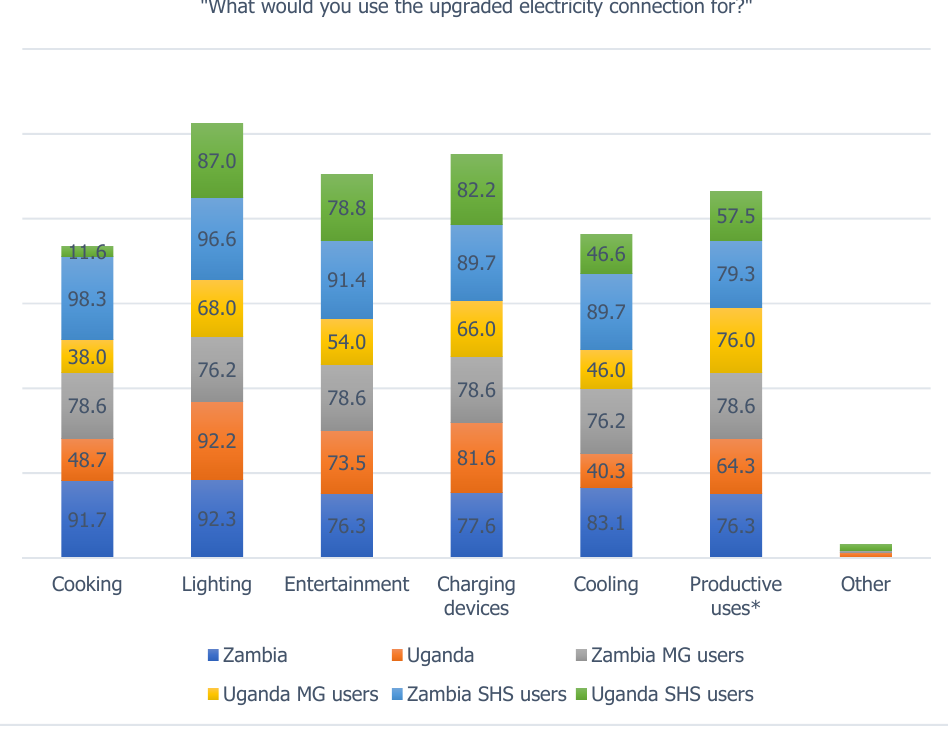
Figure 9. Energy-use demands, Consumer Groups in Uganda and Zambia (Responses in %; multiple responses; N = 1037).